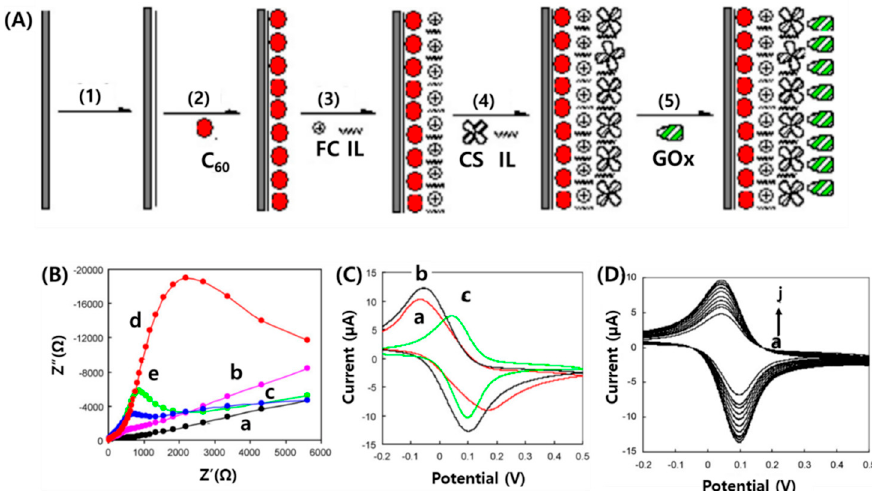
Figure 13. ( A ) General procedure for fabrication of GOx/C 60 ‐ Fc ‐ CS ‐ IL ‐ GCEW. Procedure of the electrode preparation includes five assembly processes, i.e., pretreatment of GCE, immobilization of C 60 , Fc, CS-IL, and GOx on the electrode surface. ( B ) Faradaic impedance spectra that corresponded to (a) bare GCE, (b) C 60 -GCE, (c) C 60 -Fc-GCE, (d) C 60 -Fc-CS-IL-GCE, and (e) GOx / C 60 -Fc-CS-IL-GCE, respectively, in pH 7.0 PBS containing 1.0 mM of [Fe(CN) 6 ] 3 − / 4 − . ( C ) Cyclic voltammograms of (a) Fc-GCE, (b) C 60 -Fc-GCE, and (c) GOx / C 60 -Fc-CS-IL-GCE in pH 7.0 PBS at 100 mV / s. ( D ) Cyclic voltammograms of GOx/C 60 ‐ Fc ‐ CS ‐ IL ‐ GCE in pH 7.0 PBS at 10, 25, 50, 75,100, 200, 300, 400, 500, and